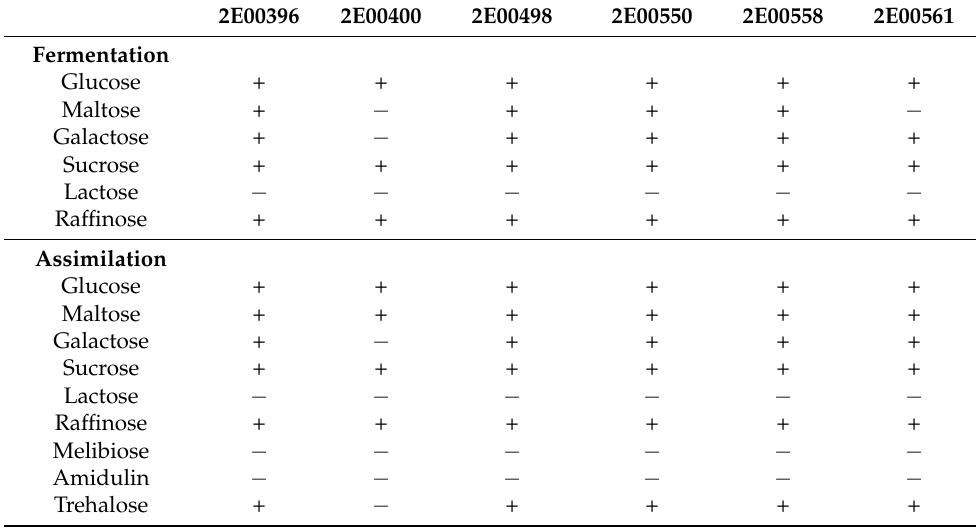
Table 2. Results of carbohydrate fermentation tests and carbon assimilation of the marine